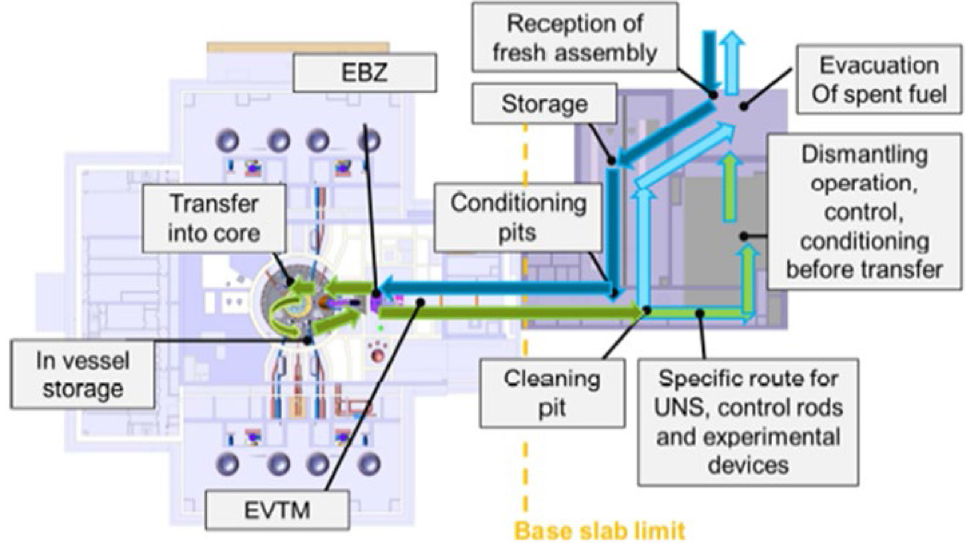
Fig. 9. FHS in ASTRID 600.